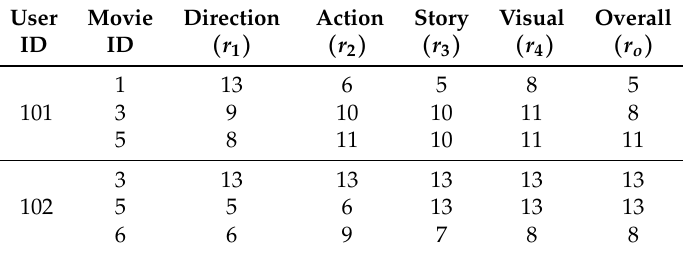
Table 3. Sample of the numerical representation of the